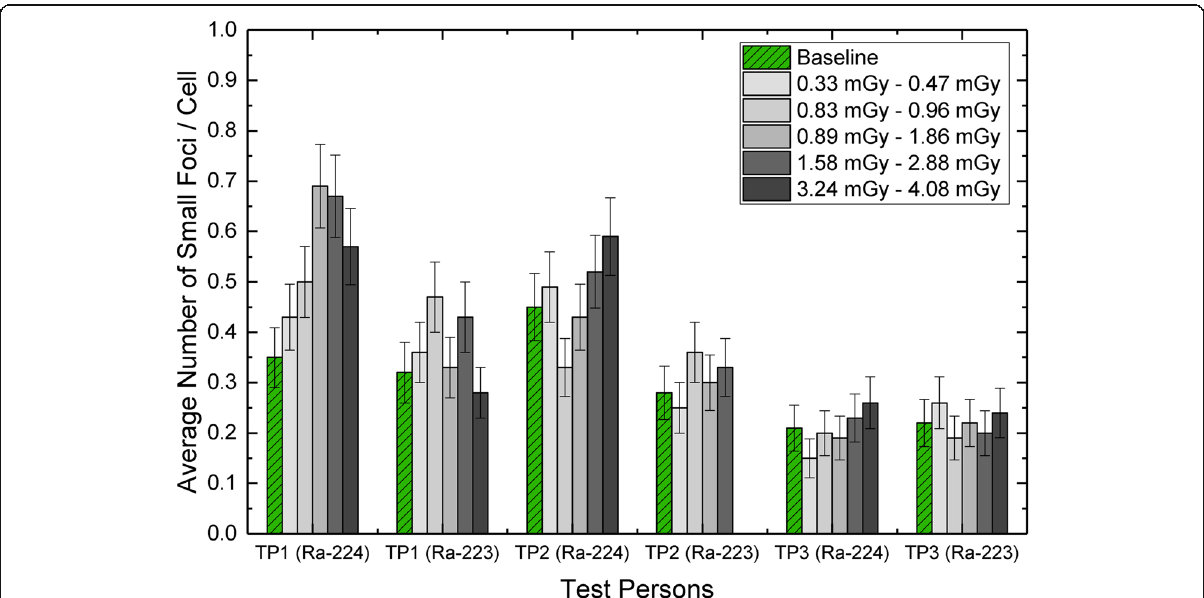
Fig. 4 Average number of β -indicating small DSB damage foci per cell in samples irradiated with Ra-224 compared to Ra-223-irradiated samples (taken from [19]) of the same three test persons. The values for the non-irradiated baseline samples are plotted in green (with pattern); the irradiated samples are plotted in gray scale. The ranges of the corresponding β -doses are stated in the legend box to the upper left. The error bars along the Y -axis denote the standard deviation of each value assuming a Poisson